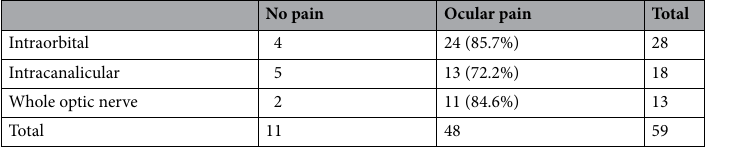
Table 2. The pattern of ocular pain depending on the location of lesions on MRI. Ocular pain was noted in the 48 patients (81.4%). However, there was no statistical difference among the three groups ( p = .673, Chi- square